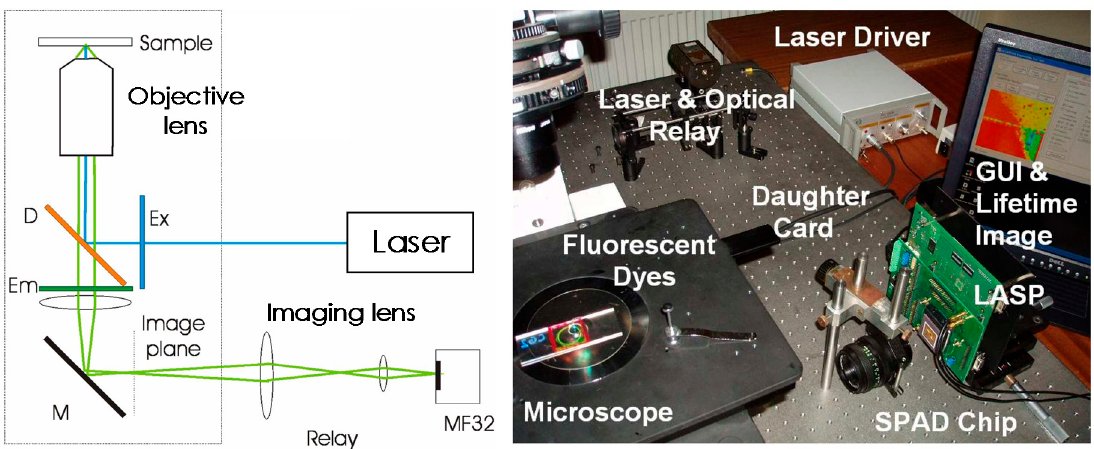
Figure 3. Schematic and photo of a conventional optical system of time-resolved fluorescence system (MF32). LASP is the motherboard of the SPAD array daughterboard. © (2010) Optical Society of America. Adapted, with permission, from [57].